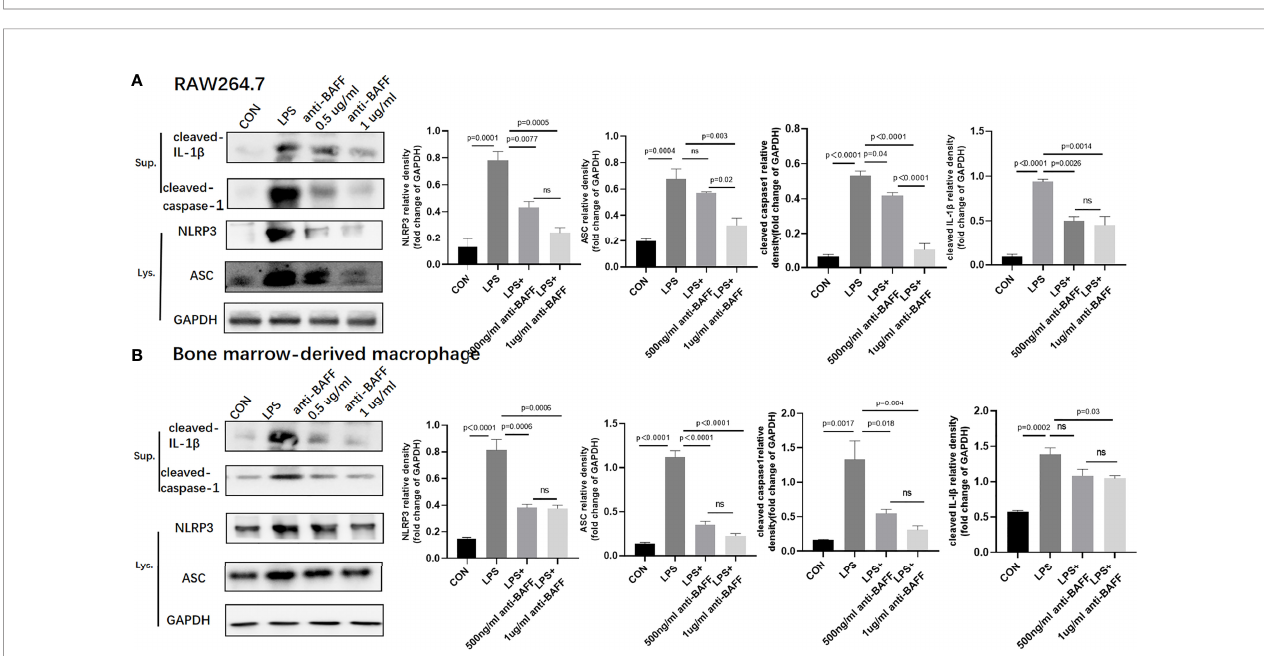
FIGURE 8 | Anti-BAFF antibody inhibited NLRP3 in fl ammasome protein in RAW264.7 cells and bone derived macrophages (BMDMs). RAW264.7 cells and BMDMs were primed with LPS (1 ug/ml) for 6 h. Anti-BAFF antibody or mouse immunoglobulin G1 (IgG1) isotype control antibody at 500 ng/ml or 1 ug/ml in the presence of LPS 1 ug/ml for 6 h, then BMDMs pulsed with ATP (2 mM, Sigma-Aldrich, MO, USO) for 30 min. (A, B) Representative immunoblot bands for the NLRP3, ASC, cleaved-IL-1 b , cleaved-caspase-1 proteins. GAPDH was used as a loading control. ns, P >